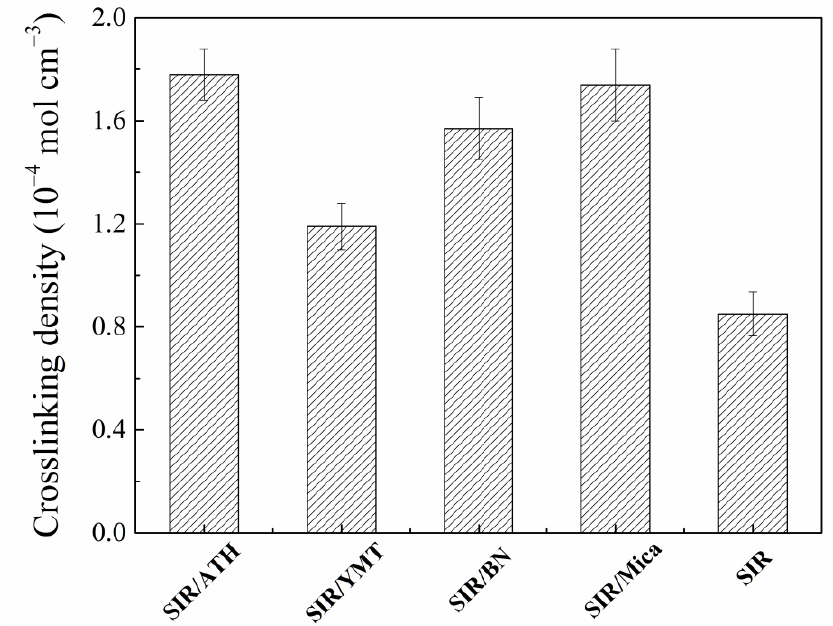
Figure 3. Crosslinking density of SIR composites with various fillers.